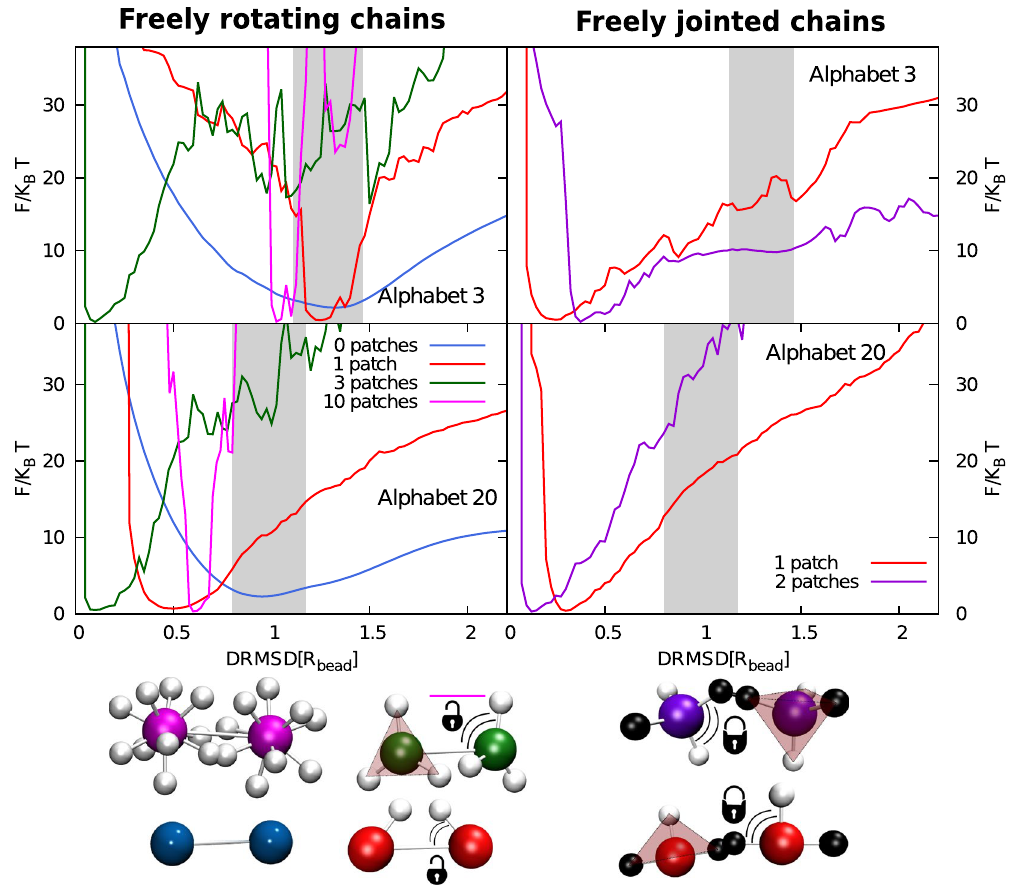
Figure 4. FOLDING free energy landscapes for some significant cases. The free energy is plotted as a function of the distance root mean square displacement ( DRMSD ) for FRC (left panels) and FJC (right panels), for different patch numbers and alphabet sizes q at temperature 0.4. DRMSD = 0 corresponds to the target structure. We define as molten globule region for each alphabet size (grey area) the DRMSD range spanning 1 k B T from the position of the global minimum of the free energy of the corresponding bare polymer without patches. All global minima with DRMSD values below the grey area are considered correctly folded (see Methods for details), see Fig. 1 for examples of folded and molten globule structures. The geometry of the patches is reported on the bottom of the figure, with colours corresponding to the free energy curves. The global minimum of the system with 10 patches and q = 3 is at the border with the grey area and it has been categorised as not